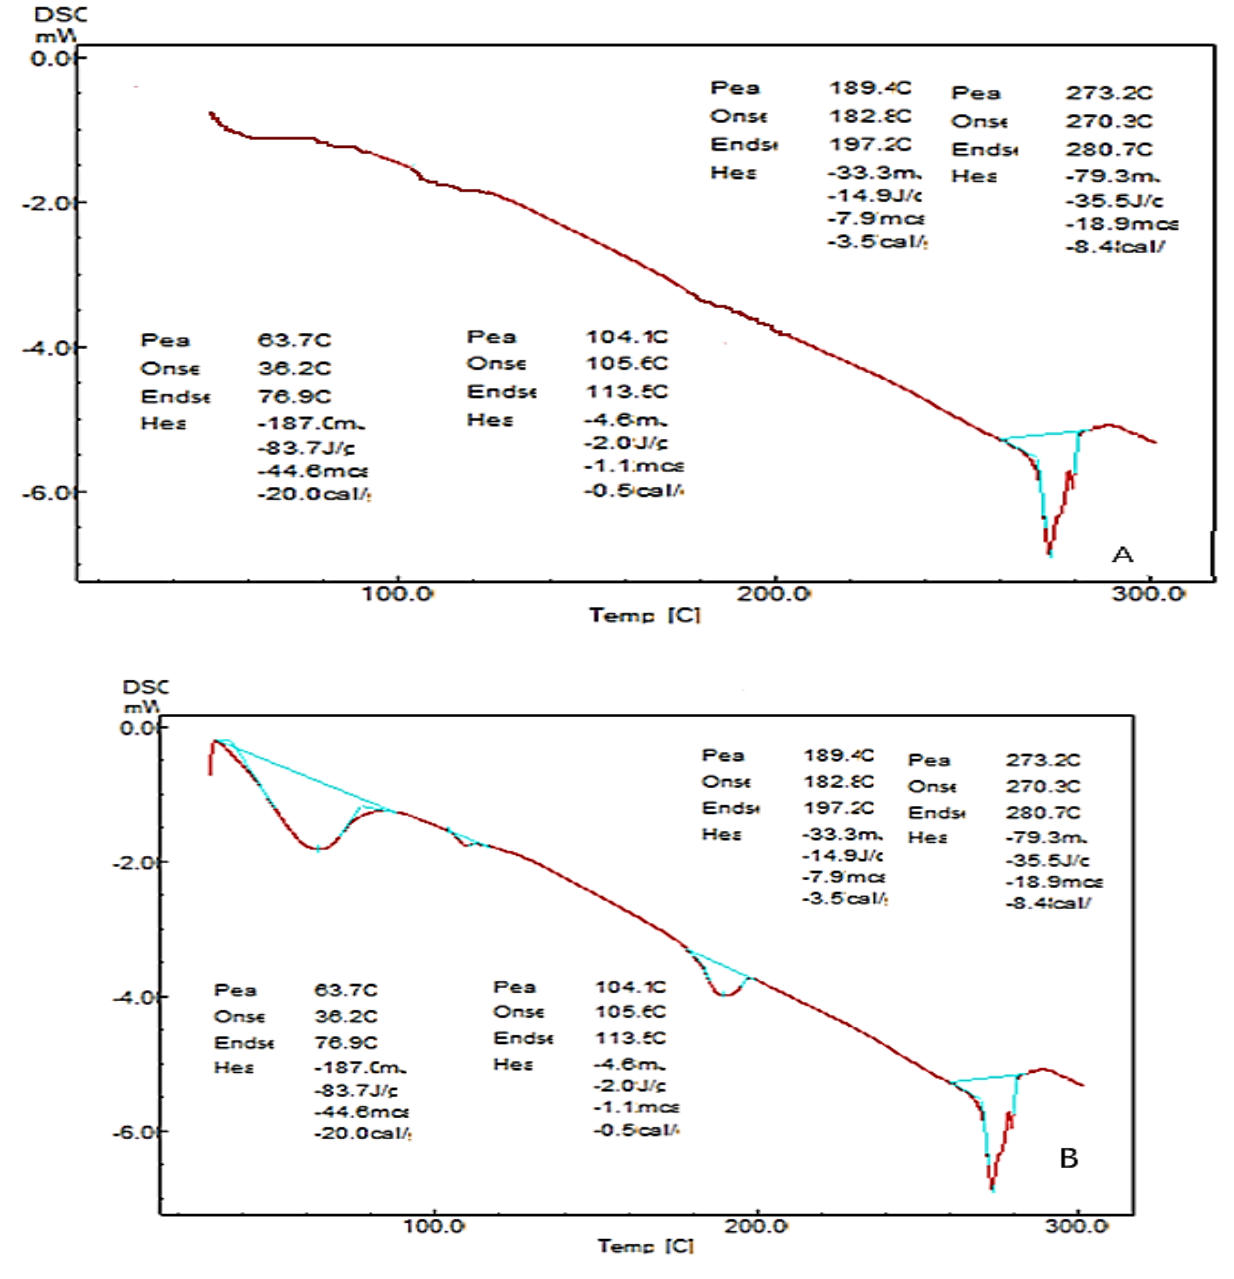
Figure 5. DSC thermograms of ( A ) pure drug and ( B ) nanocarrier.